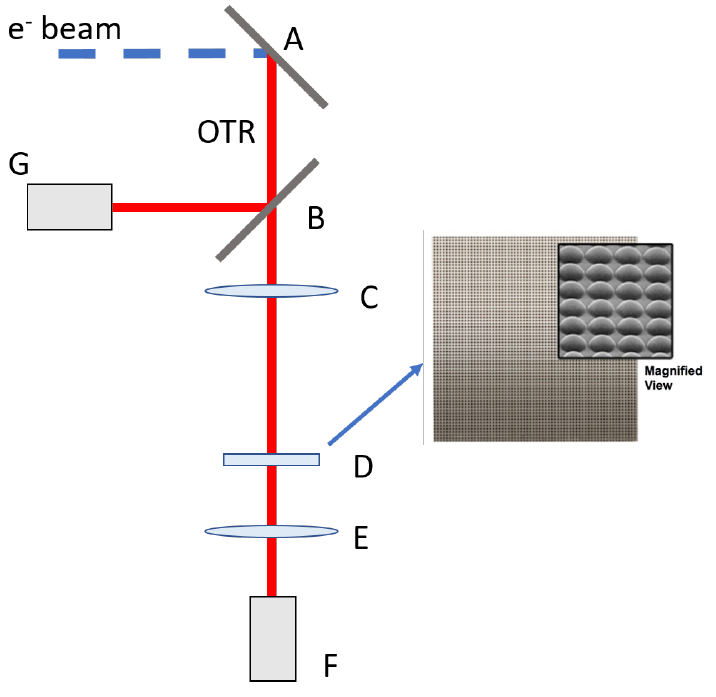
Figure 9. The radiation produced by the electron beam impinging on an aluminium-coated silicon screen ( A ) can follow two different paths, thanks to a beam splitter ( B ). In one arm, the radiation is collected by a f = 400 mm achromatic doublet ( C ) whose image plane hosts a microlens array ( D ), 10 mm × 10 mm size with 300 µ m pitch, 18.7 mm focal length plano-convex lenses. The microlens focal plane is imaged onto an intensified CCD camera ( F ) by means of a 50 mm focal length achromatic doublet ( E ). The second arm of the setup is used to image the radiation produced on the metallic screen in order to measure the transverse beam profile on a high quantum efficiency CCD camera ( G